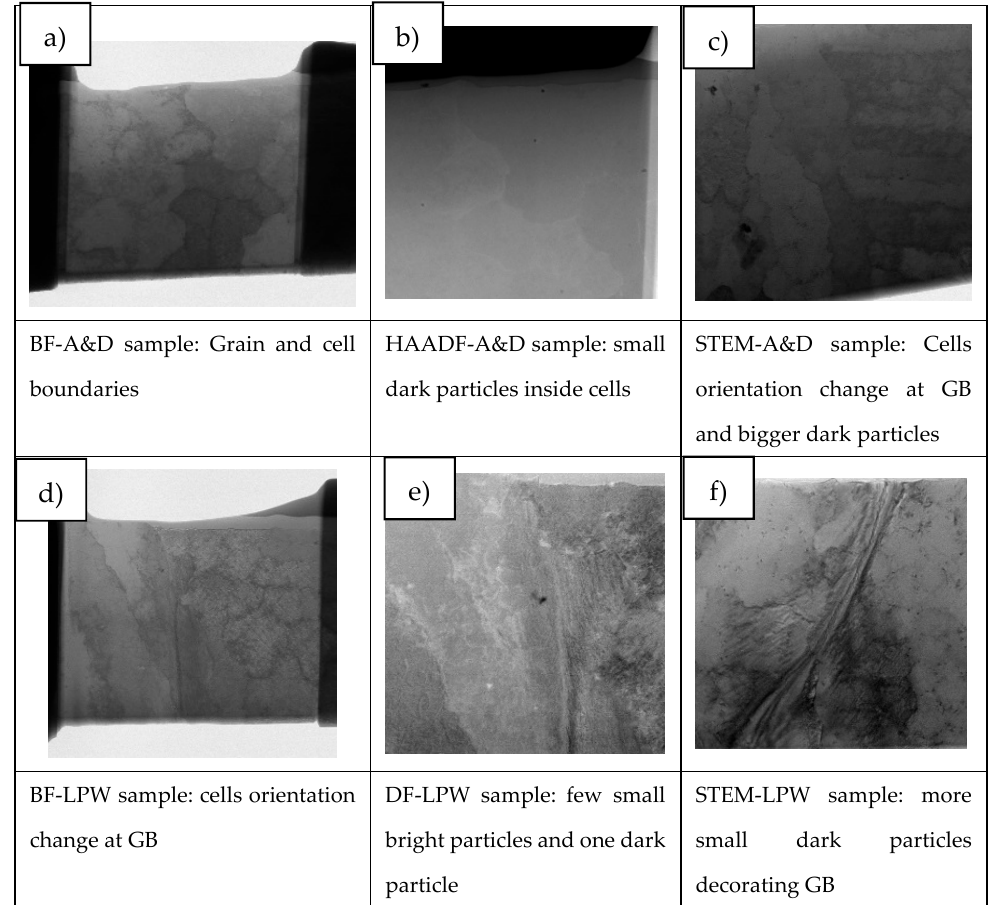
Figure 5. Different mode images of the lamellas lifted out from A&D and LPW samples: ( a ) BF of A&D sample, ( b ) A&D sample image obtained by HAADF detector, ( c ) A&D sample image in the scanning (STEM) mode, ( d ) BF of LPW sample, ( e ) LPW sample obtained by HAADF detector and ( f ) LPW sample image in the scanning (STEM) mode.